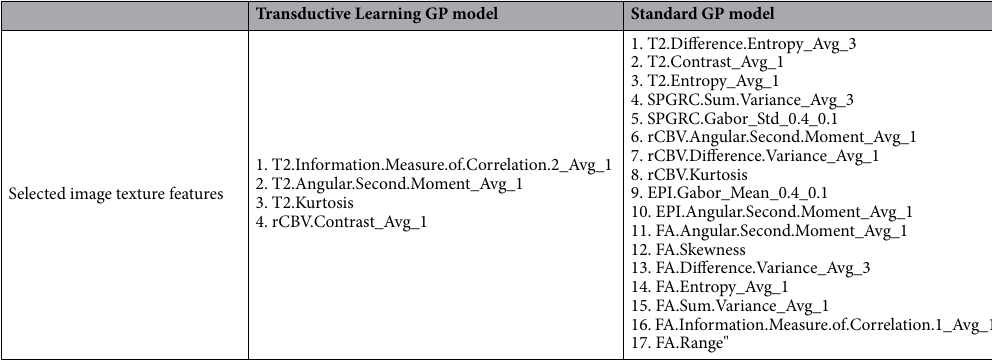
Table 1. Differences in image features and model complexity when comparing standard GP and transductive learning GP models. The transductive learning model, which prioritized model uncertainty during the training process, comprised fewer image features and lower complexity compared with the standard GP